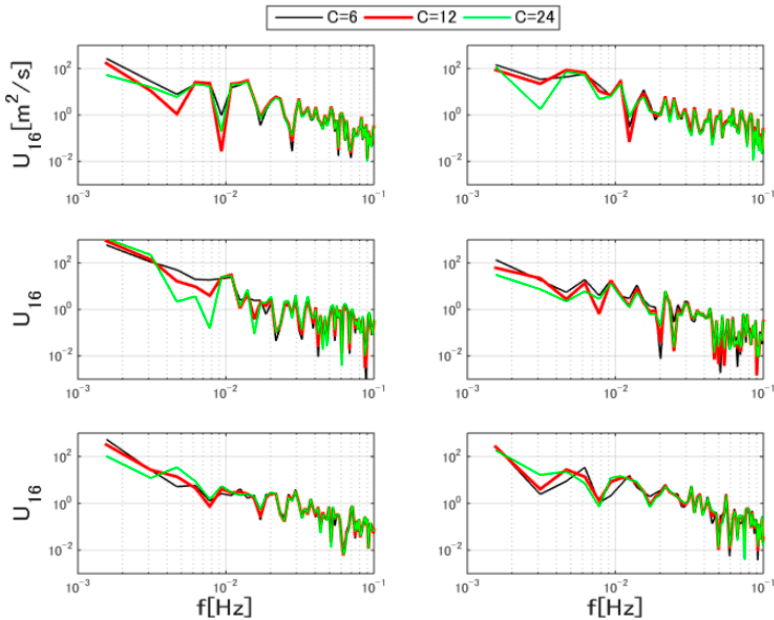
Figure 3. Example of power spectral densities (PSDs) of the longitudinal wind speed at the #1–#6 hub centres (16 m/s).